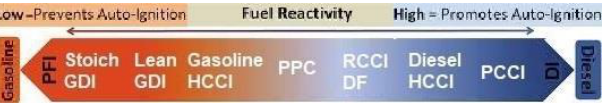
Fig. 3. The dependence of the methods of ignition of the air-fuel mixture in IC piston engines on the method of fueling the engine and the type of